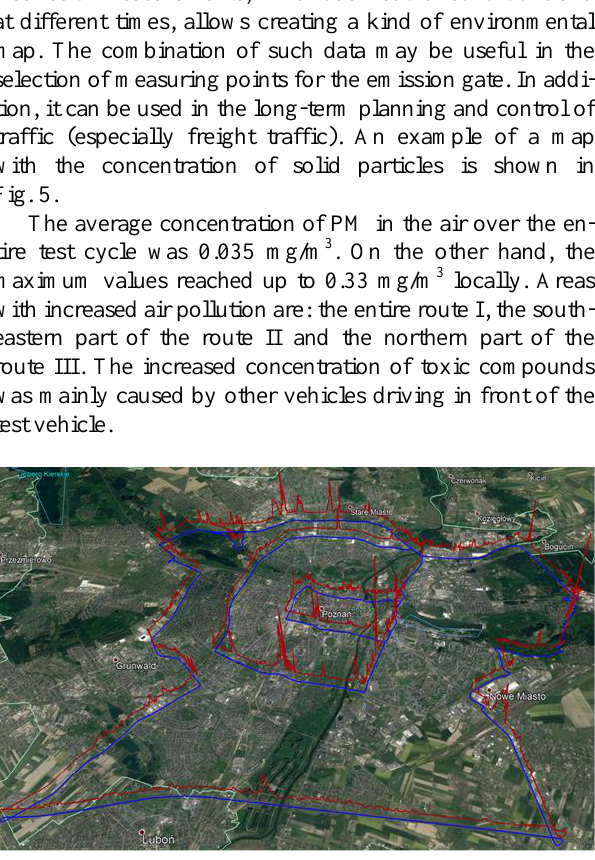
Fig. 5. Local ambient PM concentration during road tests